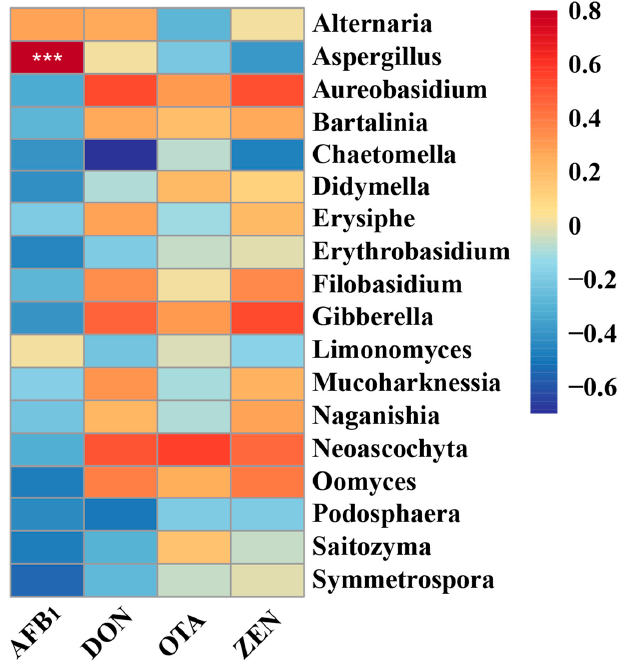
Figure 6. Heatmaps of Pearson’s correlations between dominant genera and mycotoxin. Red represents a positive correlation, while blue represents a negative correlation. Levels of significant are shown as follows: *** p < 0.001. AFB1, Aflatoxin B1; DON, Deoxynivalenol; OTA, Ochratoxins A; ZEN, Zearalenone.